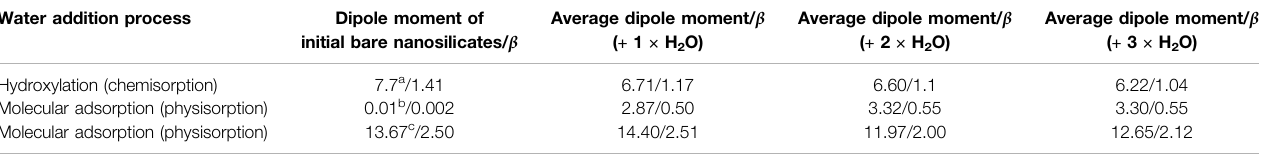
TABLE 1 | Evolution of total dipole moments ( μ ) in Debyes of (MgSiO 3 ) 6 nanosilicates with increasing hydration via hydroxylation (chemisorption) and molecular water adsorption (physisorption). The average dipoles of the hydrated nanosilicates are based on the data obtained herein and shown in Figures 2 – 4 . Values of β are calculated as β (cid:1) μ / √ N atoms .